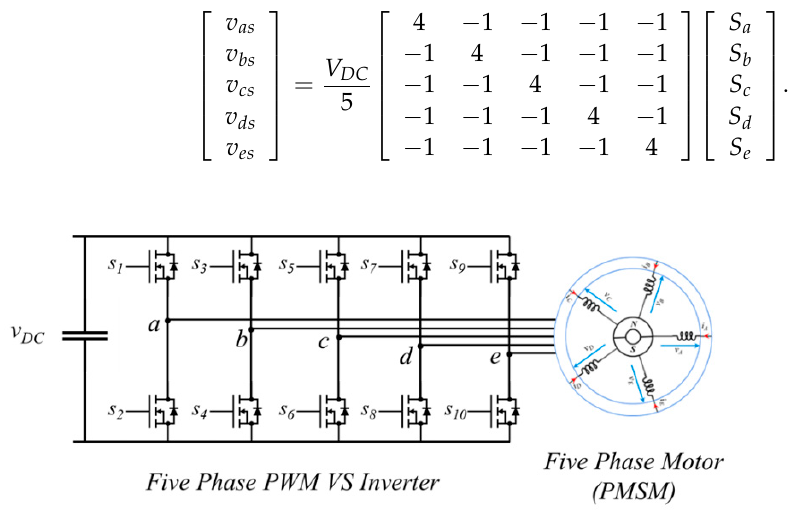
Figure 4. Five-phase Voltage Source Inverter (VSI) topology.